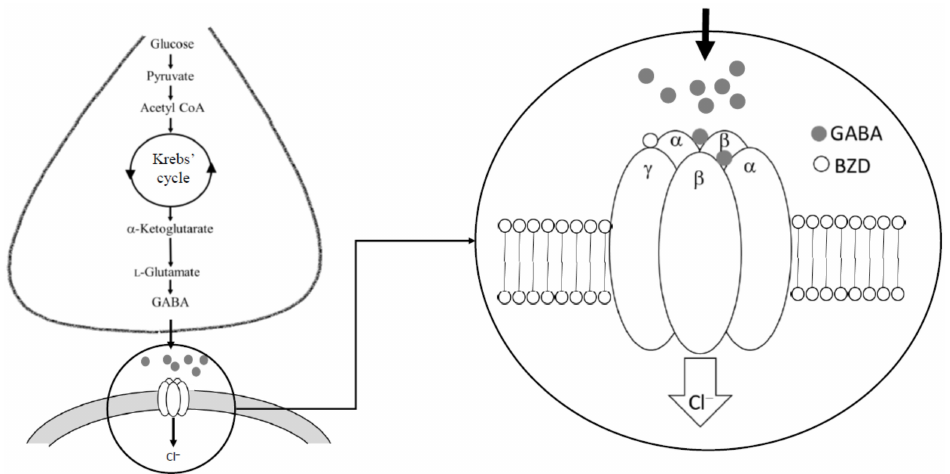
Figure 1. Synthesis of GABA and the GABA A receptor with agonist and antagonist binding